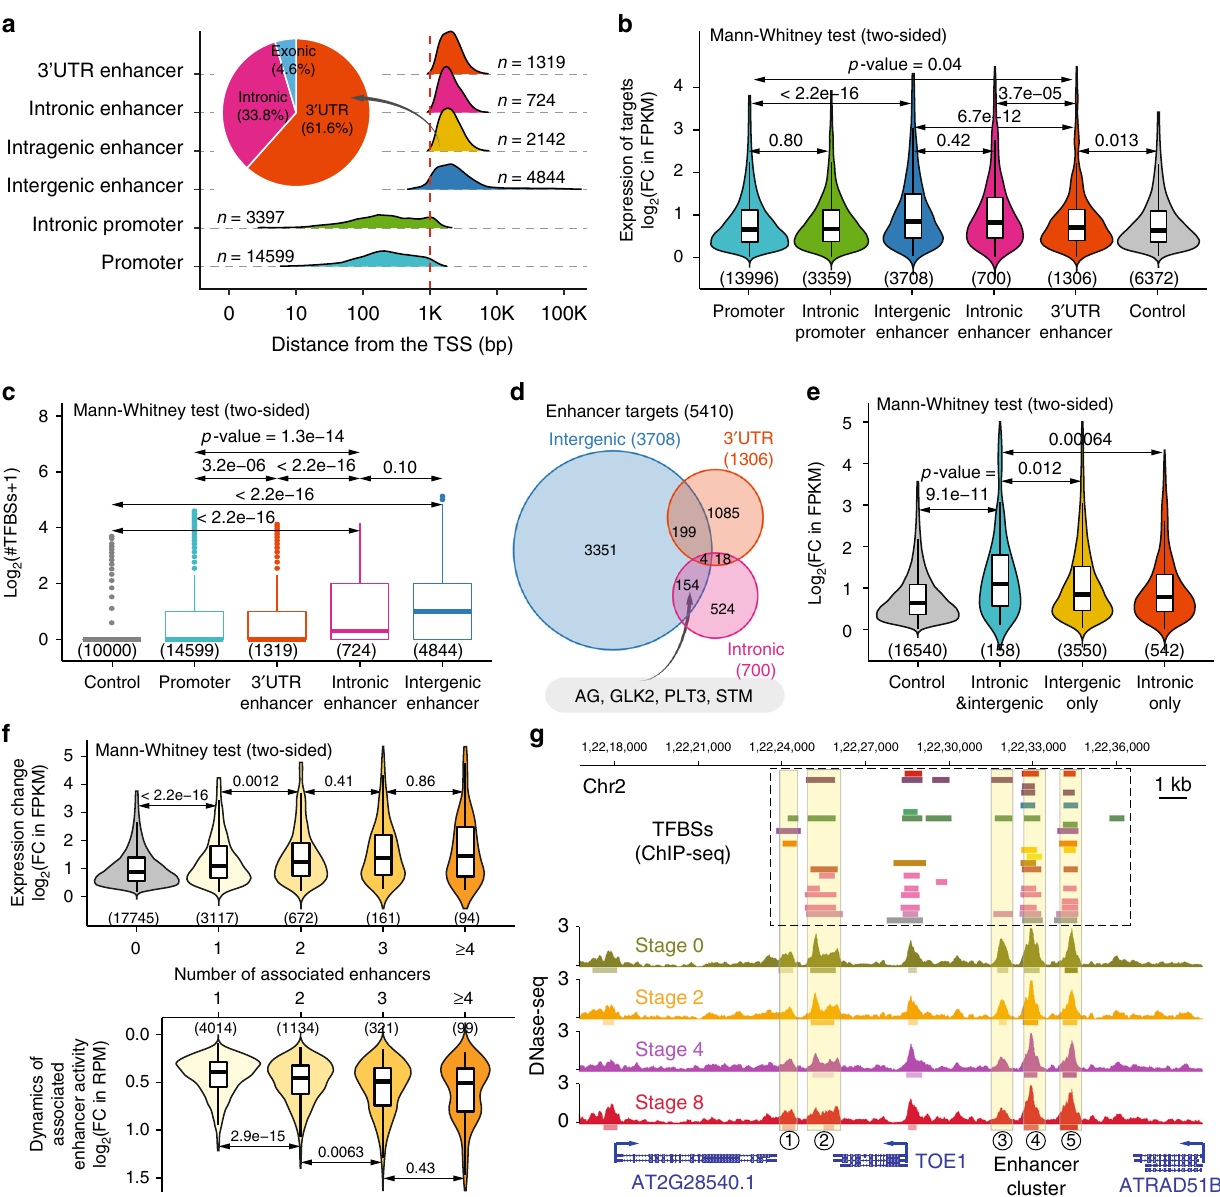
Fig. 7 Intragenic enhancers and enhancer clusters. a Distribution of the distance of cis -regulatory elements from the TSS. Inset pie chart depicts the genomic context of intragenic enhancers. The number of elements in each category is indicated. b Violin plots (with boxplots inside) showing expression dynamics of predicted target genes. The y axis is the highest log2-transformed fold change (FC) of expression levels (in FPKM) during fl ower development. The number of predicted target genes in each category is shown in parentheses. c Boxplots showing the distribution of the number of transcription factor binding sites (TFBSs; data from ref. 48 ) overlapping with cis -regulatory elements in each category. In the analysis, 10000 random genomic regions are used for control. Boxplots show the median (horizontal line), second to third quartiles (box), and Tukey-style whiskers (beyond the box). d Venn diagram showing the overlap of target genes for intergenic and intragenic enhancers. Example genes with both intergenic and intronic enhancers are shown in the box below. The total number of genes in each category is shown in parentheses. e Violin plots (with boxplots inside) showing expression dynamics of target genes with intergenic enhancers only, with intronic enhancers only, and with both intergenic and intronic enhancers. Genes without any enhancers are used for comparison. f Violin plots (with boxplots inside) showing expression changes of target genes (top panel) or the change of enhancer activity (in RPM, calculated based on chromatin accessibility/DNase-seq data; bottom panel) over the four developmental stages with increasing number of associated enhancers. Only intergenic and intronic enhancers were considered. The number of enhancers (bottom) and predicted target genes (top) in each category is labeled in parentheses. Genes without any enhancers are used for comparison. b , c , e , f Boxplots show the median (horizontal line), second to third quartiles (box), and Tukey-style whiskers (beyond the box). BS binding sites. g Genome browser view of annotated enhancers at the locus of TOE1 . Putative enhancers are numbered. Please note that the fi fth enhancer could belong to the next gene ATRAD51B based on genomic distance. See Fig. 4j for the color code of tracks. The underlying source data for a – c and e , f are provided in the Source Data fi